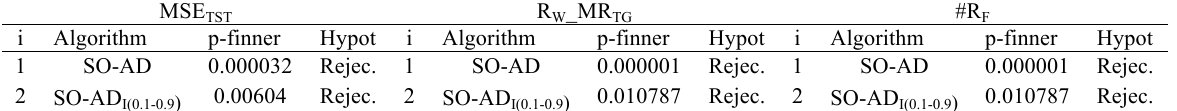
Table B.5 Finner Table with α = 0.05 for the methods on MSE TST , R W _AvR TG and #R F measures on MAX ACC point